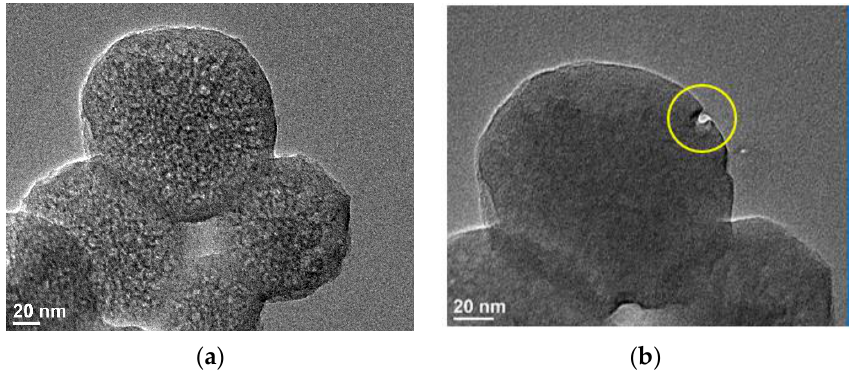
Figure 2. TEM images: ( a ) 5-[Mn III ]@RSNP; ( b ) 5-[Mn III ]@RSNP after EDX analysis, the cropped part is due to the electron beam action.